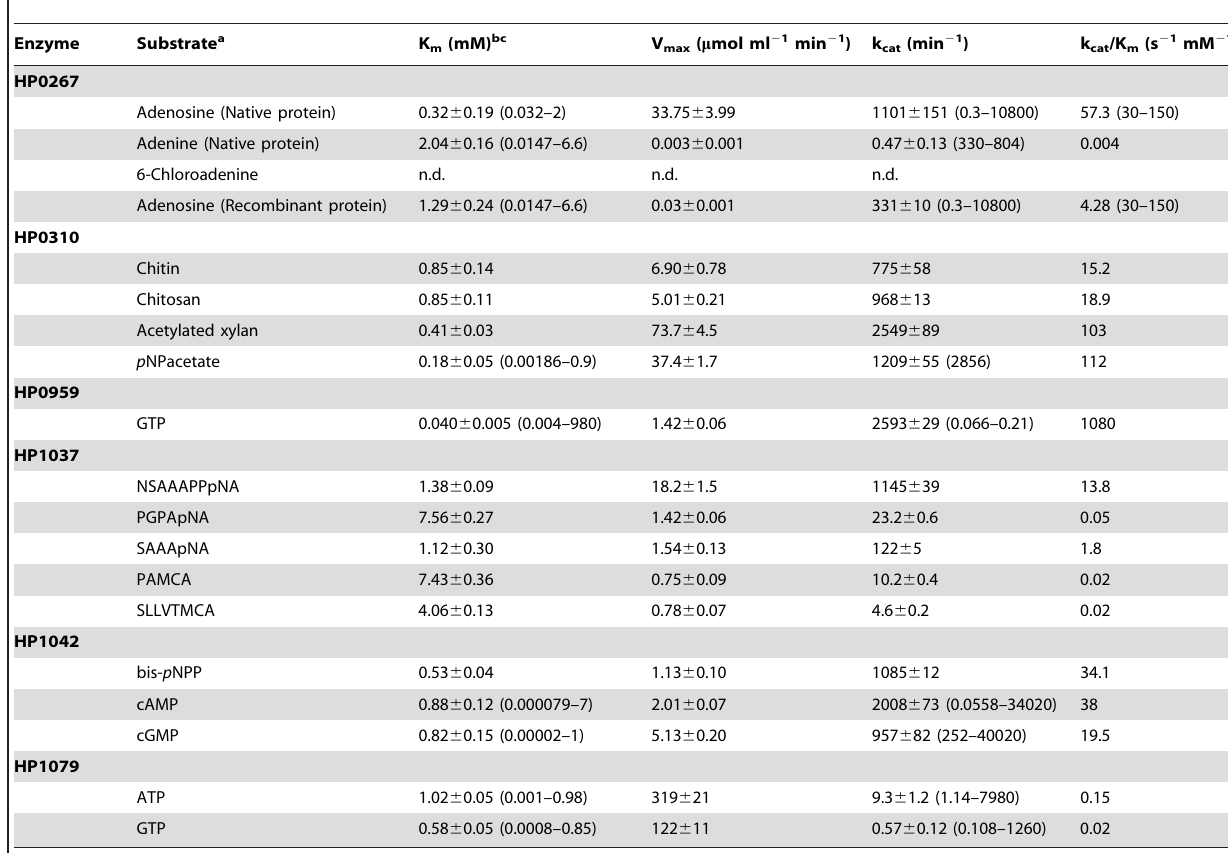
Table 1. Kinetic parameters of native pure proteins directly isolated from Helicobacter pylori .